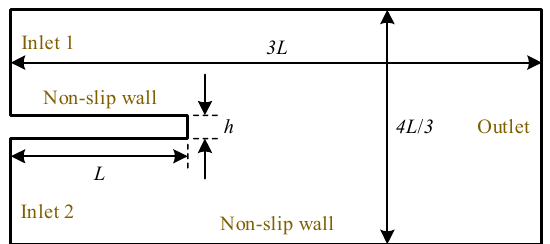
Figure 1. Computational domain and boundary conditions.